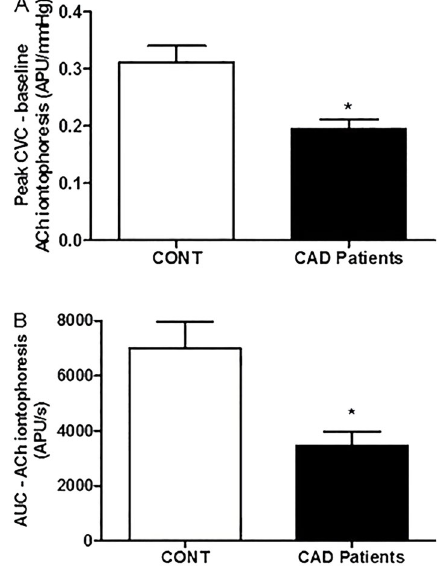
Figure 2. Effects of the skin iontophoresis of acetylcholine (ACh) on cutaneous microvascular conductance [CVC, expressed in arbitrary perfusion units (APU) divided by mean arterial pressure in mmHg] in healthy volunteers (CONT) and male patients with coronary artery disease (CAD). A , peak CVC minus baseline CVC resulting from the iontophoresis of ACh. B , area under the curve (AUC) for the iontophoresis of ACh on the skin. Data are reported as means ± SE. *P o 0.05, compared to control (two-tailed unpaired Student ’ s t -test). 3469 ± 3075 APU/s in the control and CAD participants, respectively (P=0.001; Figure 2B).